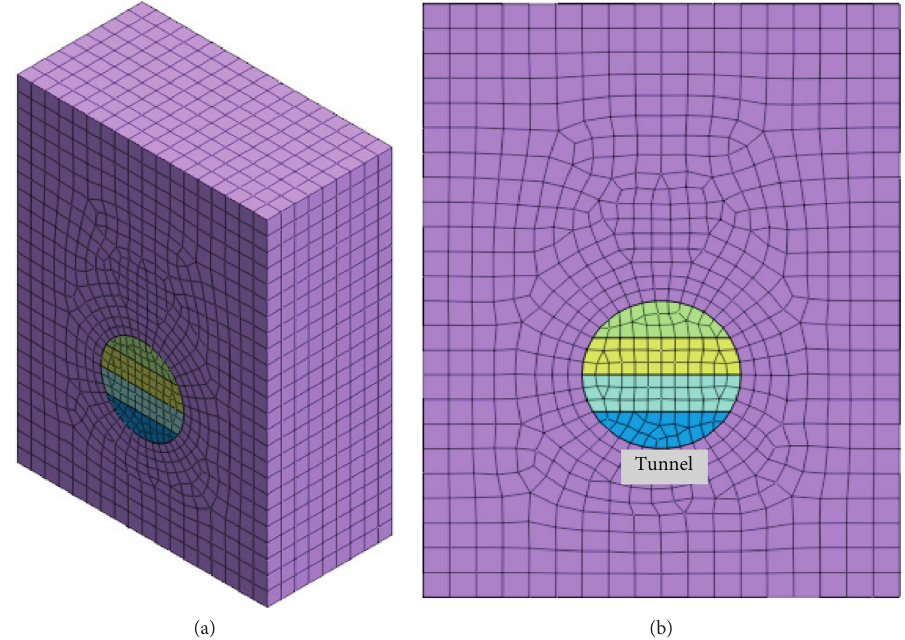
Figure 7: Tunnel excavation model without cavity. (a) Axonometric drawing. (b) Front